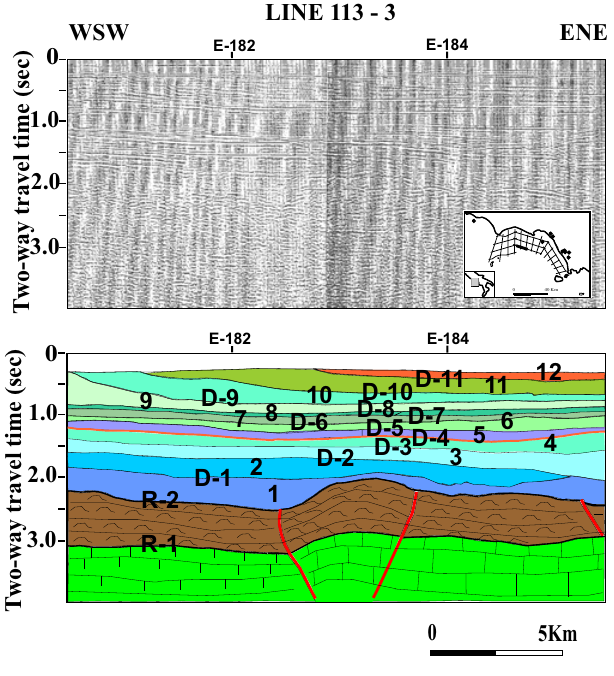
Figure 9. E113 seismic profile (from Aiello et al. [2000], slightly modified) showing the progradational sequences of the Terracina Basin, supplied by the Sisto River (Pontina Plain) during the Pleistocene. Regional unconformities: R-1, R-2, D-1, D-2, D-3, D-4, D-5, D-6, D-7, D-8, D-9, D-10, D-11. Seismic units: 1, 2, 3, 4, 5, 6, 7, 8, 9, 10, 11, 12. A "pop-up" structure in the acoustic basement has also been